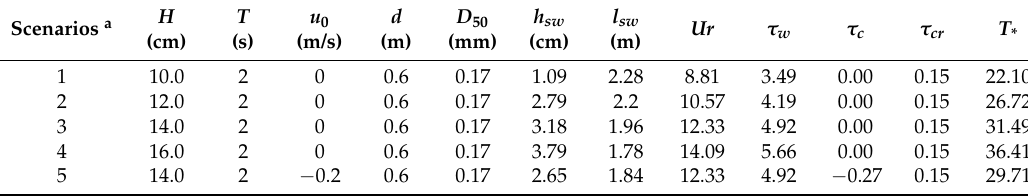
Table 2. Hydrodynamic conditions and characteristics of measured sand waves.